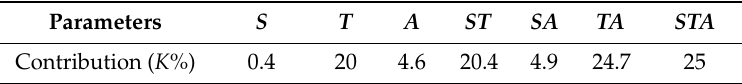
Table 7. Each factor and their